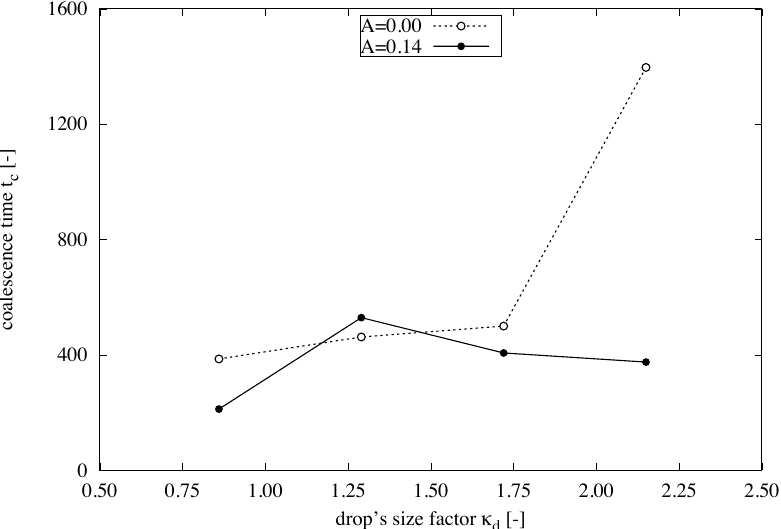
Figure 16. Trend of the coalescence time relative to the initial slug length s for the sinusoidal channel. The drop’s size factor κ d = 1.29 presented larger coalescence time t c for corrugated channels relative to the straight channels with same parameters. The others drop’s size factors presented smaller coalescence time for the corrugated channel with amplitude A = 0.14 relative to the straight channel A = 0.00. All parameters are